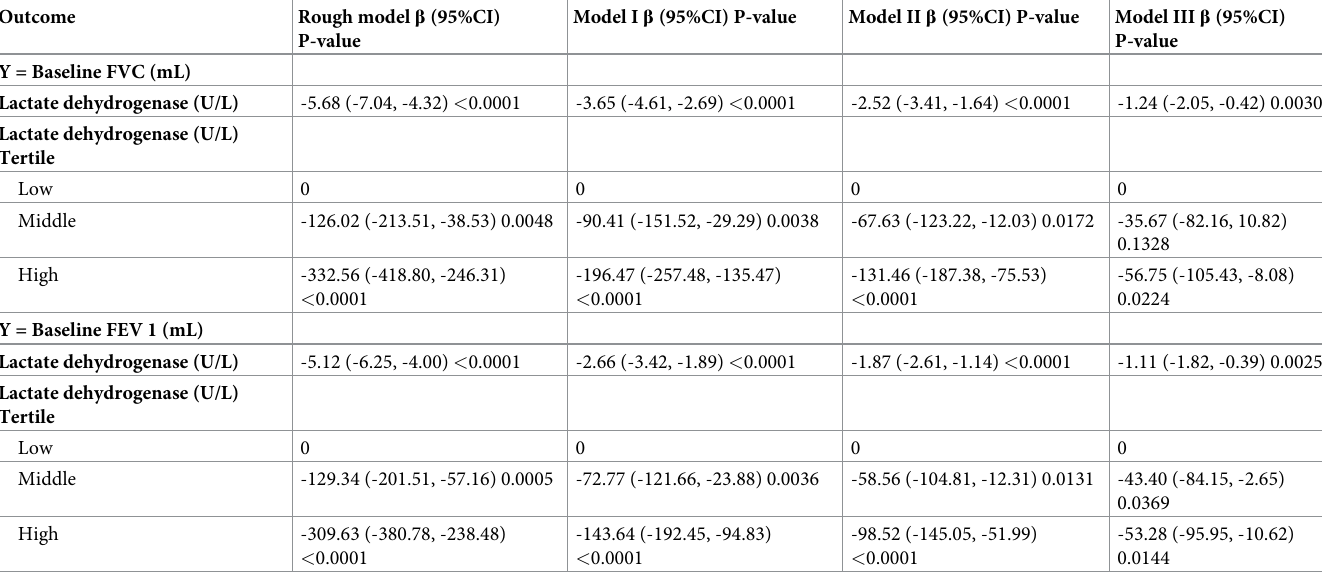
Table 3. Relationship between serum and serum lactate dehydrogenase and pulmonary function (multiple regression equation analysis).